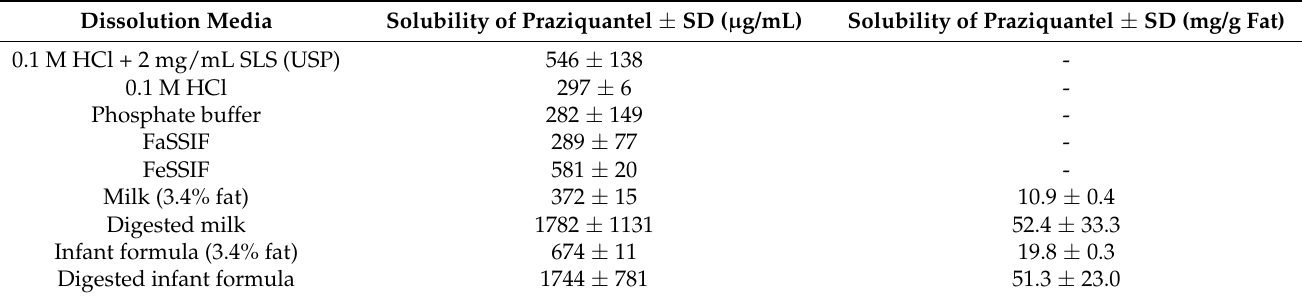
Table 1. Solubility of praziquantel in different dissolution media. Errors are standard deviation from n = 3